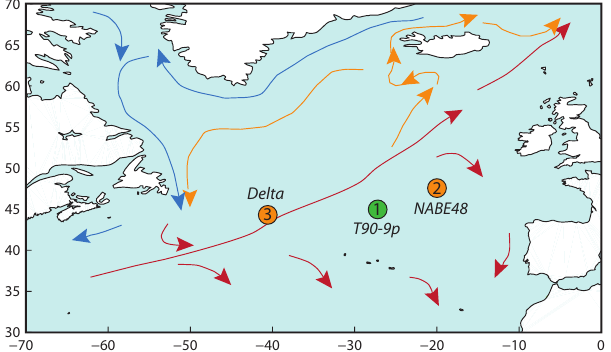
Figure 1. Location map of the North Atlantic region. Location map of (1) piston core APNAP T90-9p and long-term observation sta- tions, (2) sediment trap NABE 48 (Wolfteich, 1994) and (3) Ocean Station Delta (Bé and Tolderlund, 1971) with main surface ocean currents overlain. Colour indicates relative temperature of the dom- inant water mass, with red to blue representing warmest to coolest.